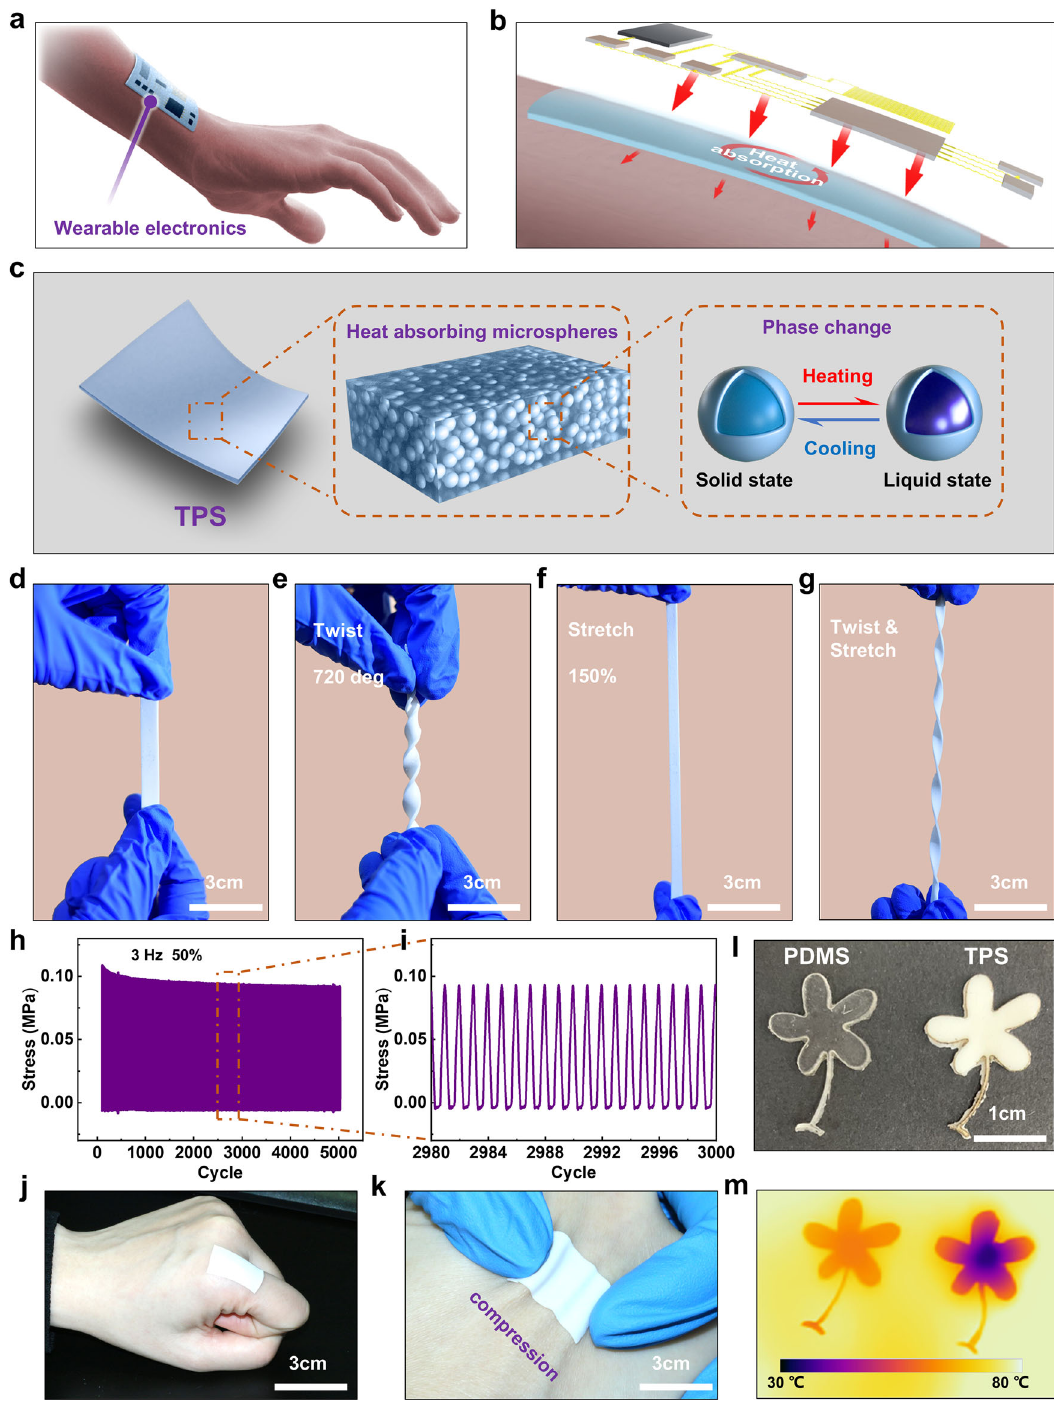
Fig. 1 Design concept and illustrations of the proposed thermal protective substrate (TPS) for wearable electronics with the capabilities of thermal insulation, mechanical compliance, and stretchability. a Schematic illustration of a wearable electronic device attached to human skin. b Schematic illustration of heat transfer from devices to skin with the TPS absorbing large amounts of heat energy. c Schematic illustration of TPS composed of a polymer matrix embedded by heat-absorbing microspheres consisting of phase change materials encapsulated by the resin shell. The solid-liquid phase change occurs during the heating and cooling processes. Optical images of TPS under various deformations: d undeformed, e twist, f stretch, and g twist/stretch. h , i Cyclic loading test of TPS under an applied strain of 50% at a frequency of 3 Hz. j TPS attached to the index fi nger joint with stretch. k TPS attached to opisthenar with compression. l Optical image of PDMS and TPS without heating. m Thermal image of PDMS and TPS after placed on 80 o C hot plate for 10 s. The TPS is composed of heat- absorbing microspheres with a mass ratio of